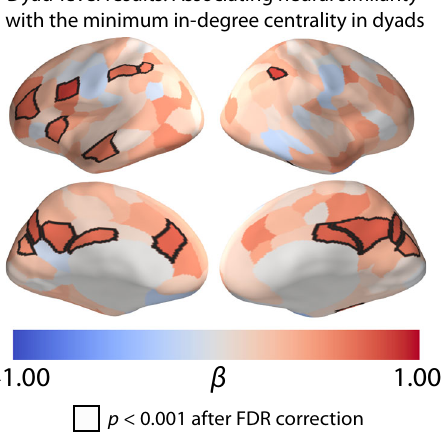
Fig. 5 Dyad-level associations of neural similarity with the minimum in- degree centrality of dyads. We found a positive association between ISC and minimum in-degree centrality. Larger ISCs in brain regions (including the DMPFC, the VLPFC, the precuneus, the temporal pole, and portions of the superior parietal lobule) were associated with a higher minimum in- degree centrality. The quantity β is the standardized regression coef fi cient. Regions where we observed signi fi cant associations between in-degree centrality and ISC are outlined in black. We used an FDR-corrected signi fi cance threshold of p < 0.001, which corresponds to an uncorrected p - value threshold of p < 8.879 × 10 − 5 . All of the reported p -values are two- tailed. Source data are provided as a Source Data fi